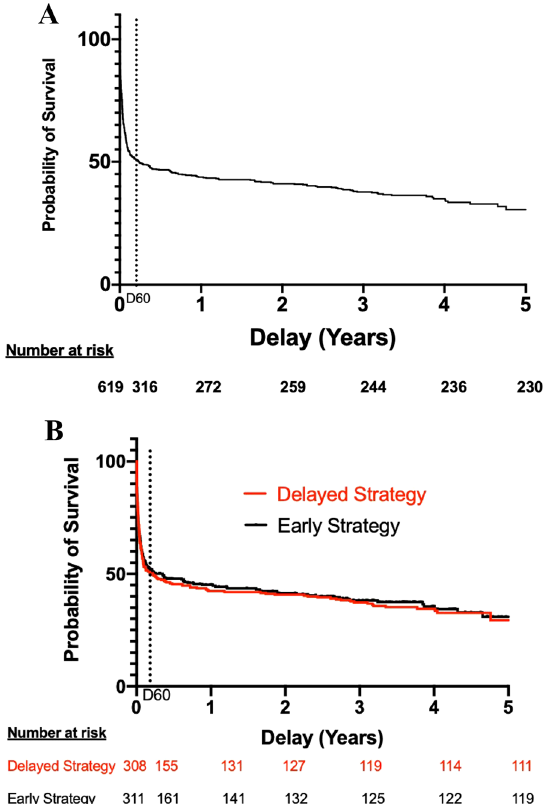
Fig. 2 Probability of survival. Panel A shows Kaplan–Meier curves of the probability of survival for all study participants from randomization to end of extended follow‑up. Panel B shows Kaplan– Meier curves of the probability of survival from randomization to end of extended follow‑up, according to RRT initiation strategy group